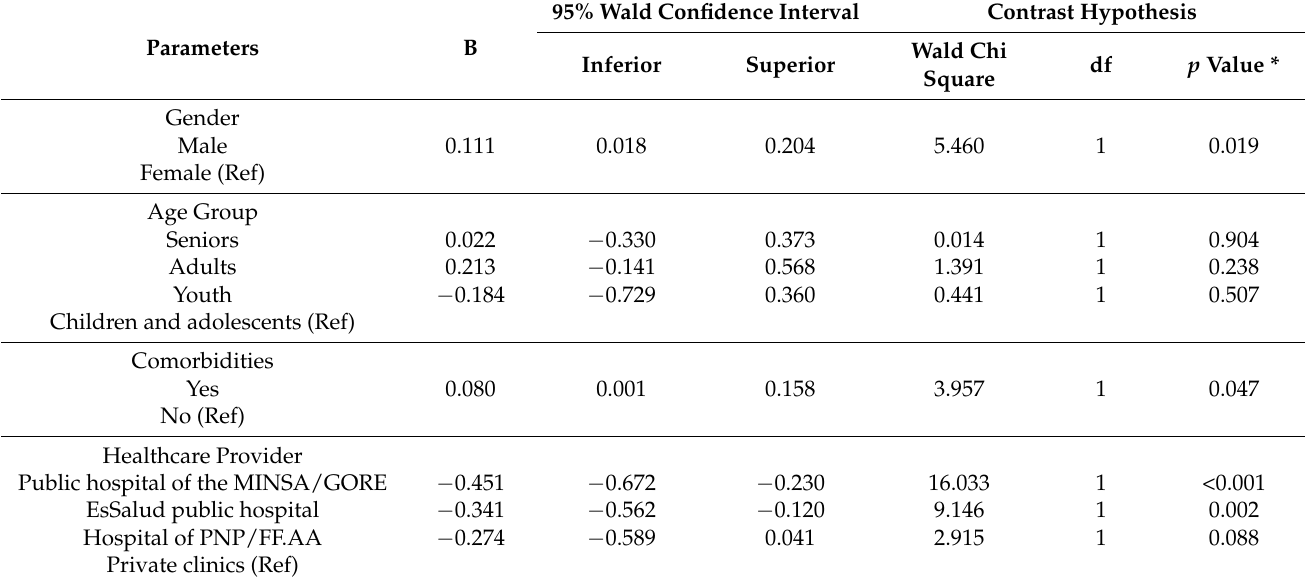
Table 6. Multivariable analysis of variables that influence on hospital time of COVID-19 deaths in Peru during the initial pandemic